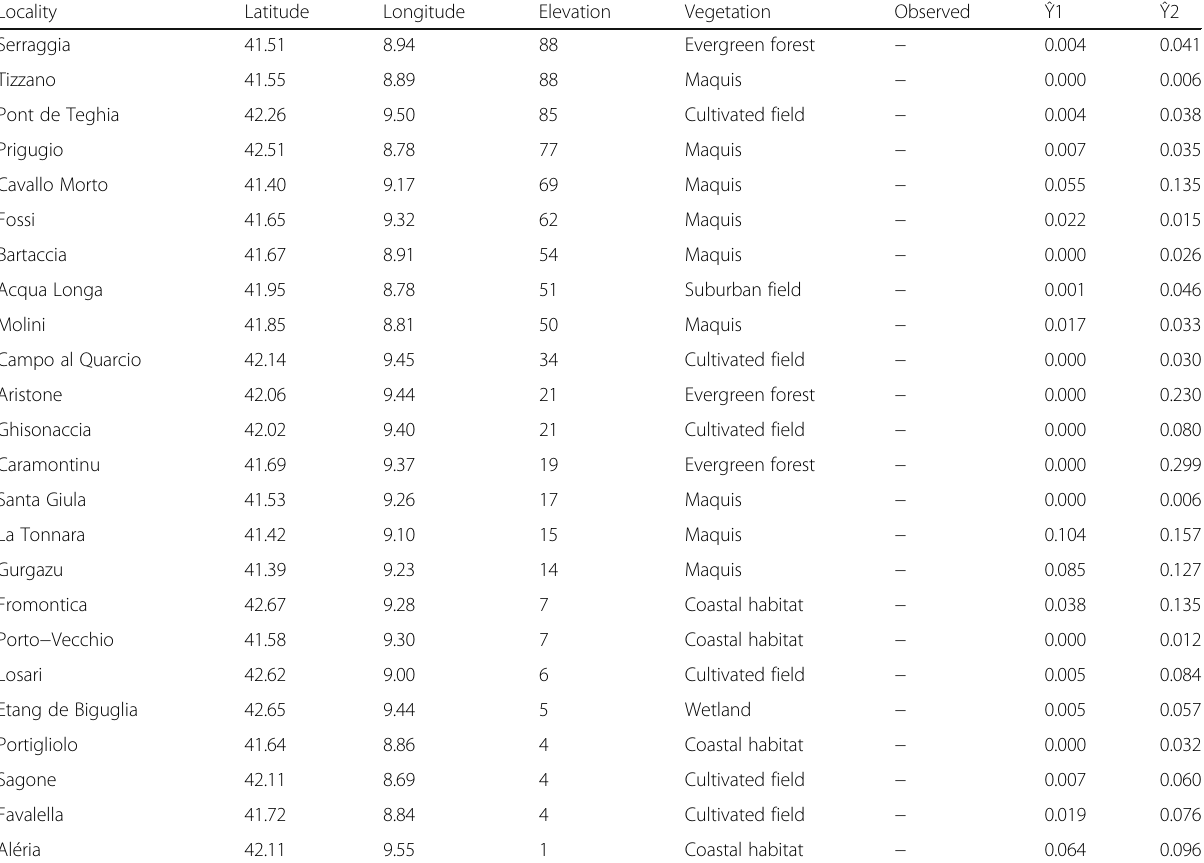
Table 3 Predicted probabilities for the presence/absence sites using random forest classification. Observed (+) = Salamandra corsica presence site; Observed ( − ) = Salamandra corsica absence site. Ŷ 1 = macro-ecological model; Ŷ 2 = mixed model. Datum for all coordinates, WGS84. Elevation, masl